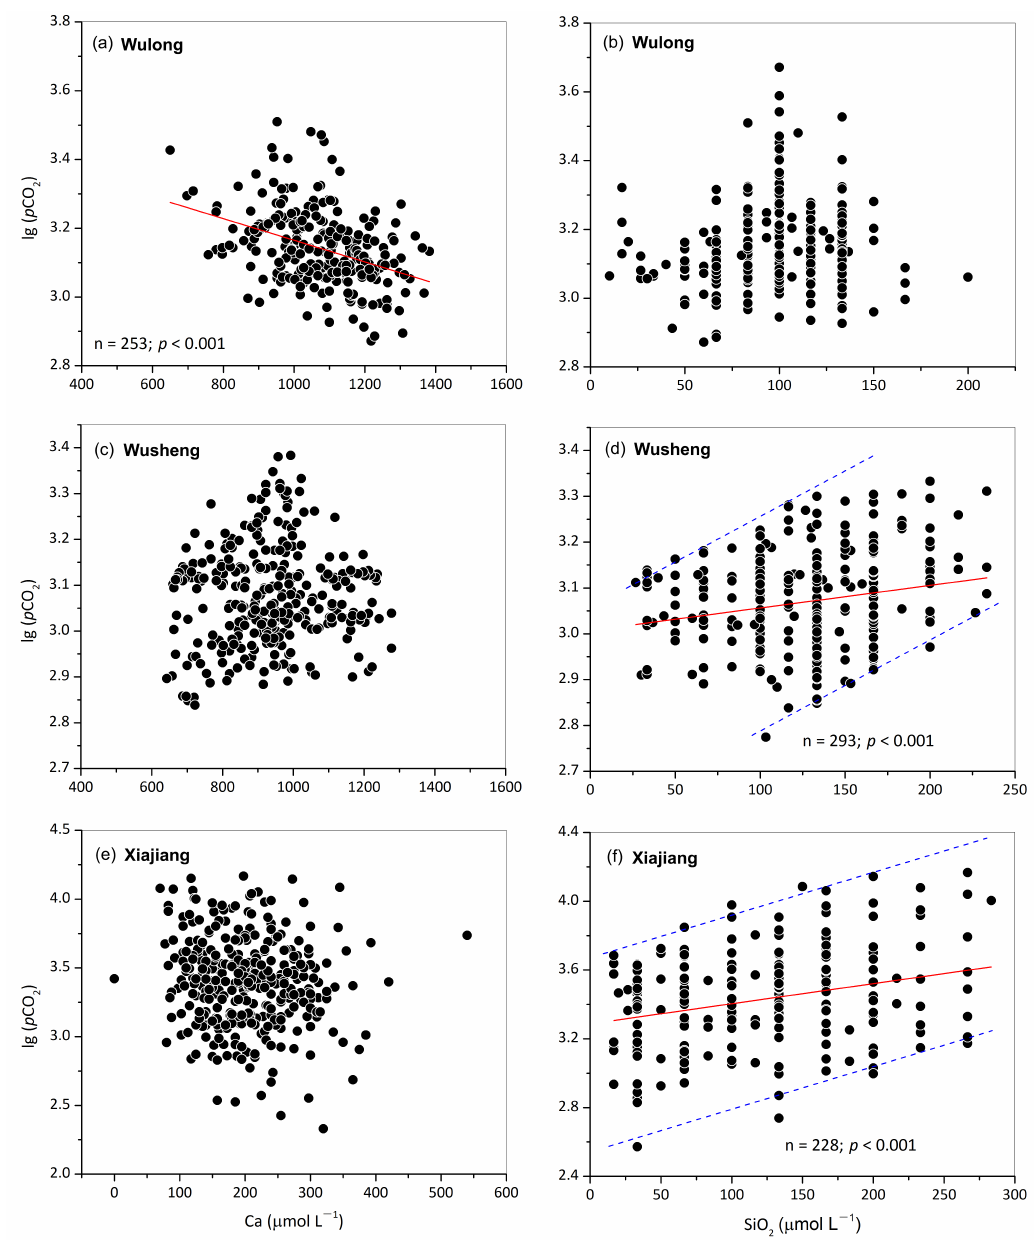
Figure 6. Responses of p CO 2 to rock weathering products in three typical catchments with distinct rock compositions: (a, b) Wujiang River (Wulong station), (c, d) Jialingjiang River (Wusheng station), and (e, f) Ganjiang River (Xiajiang station). The solid lines represent linear